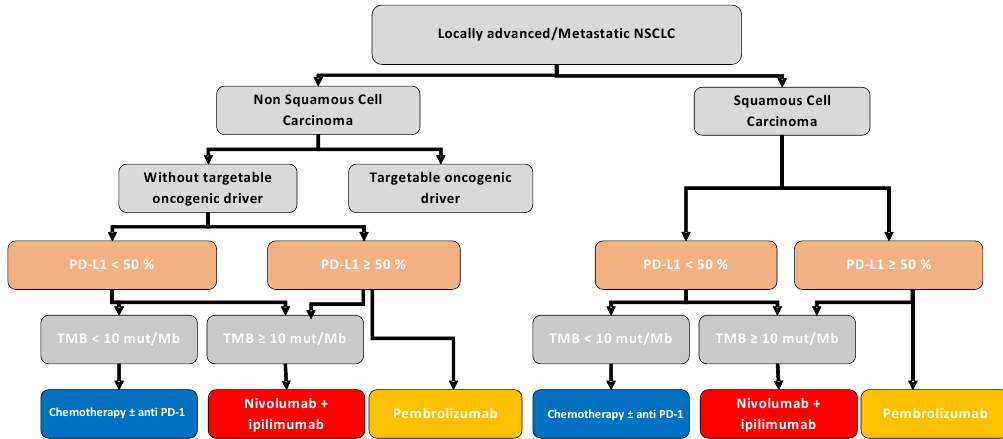
Figure 2. Involvement of TMB in the first line of NSCLC management strategy. Abbreviations: NSCLC, Non-Small-Cell Lung Cancer; Mut, Mutations; Mb, Megabase; PD-L1, Program Death-Ligand 1; TMB, Tumor Mutational